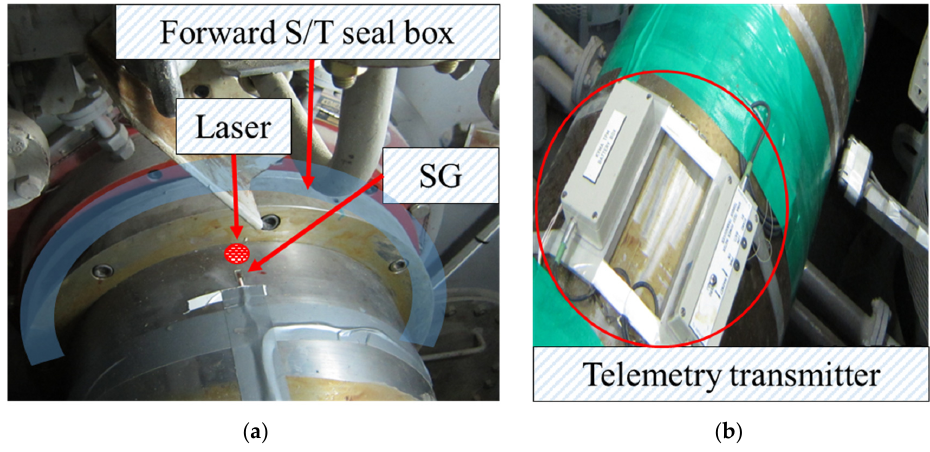
Figure 6. Installation of the sensors and the telemetry system in the engine room. ( a ): Laser displacement sensor and strain gauge installation. ( b ): Strain gauge telemetry transmitter installation.